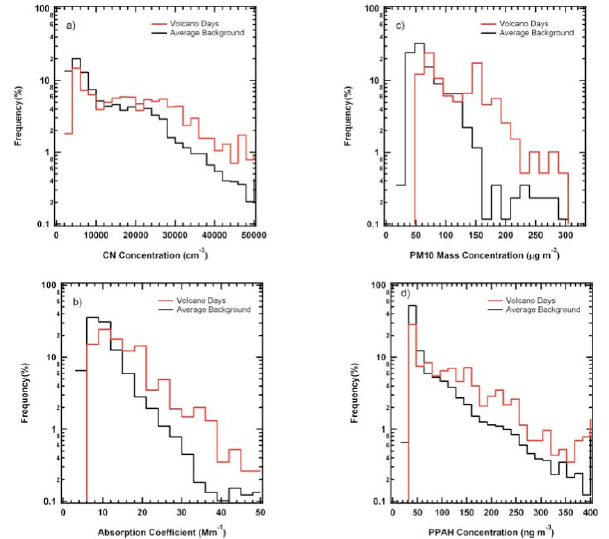
Fig. 6. Frequency distribution of the average background concen- tration (black line) and for the 8 days when volcanic influence was detected (red line), for: (a) CN concentration, (b) absorption coeffi- cient, (c) PM 10 and (d) PPAH concentration.